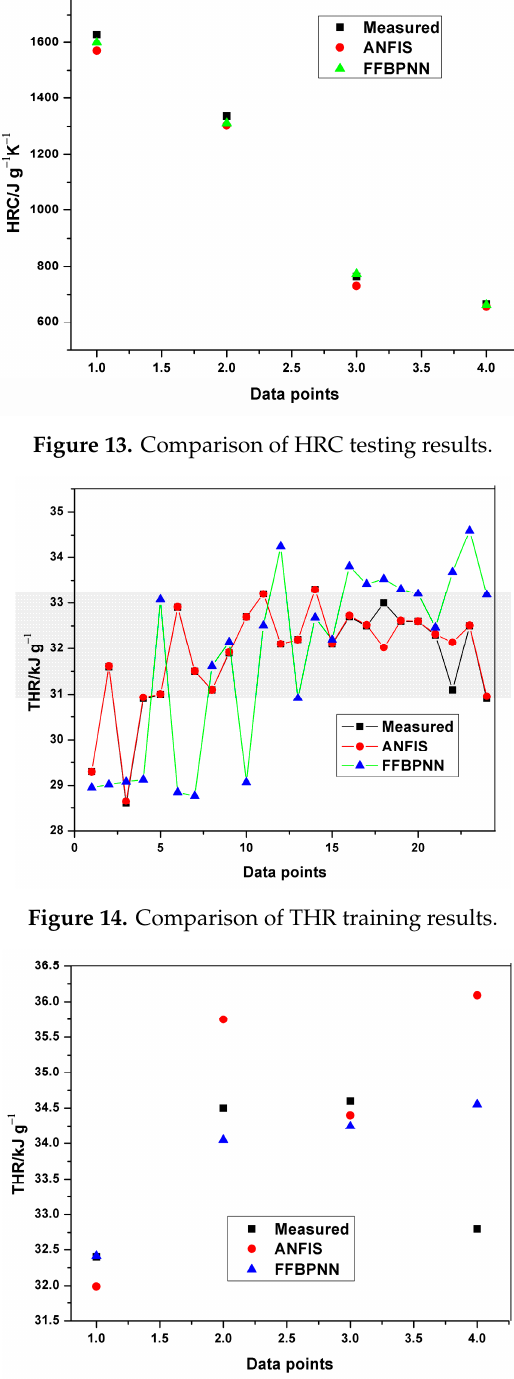
Figure 15. Comparison of THR testing results.